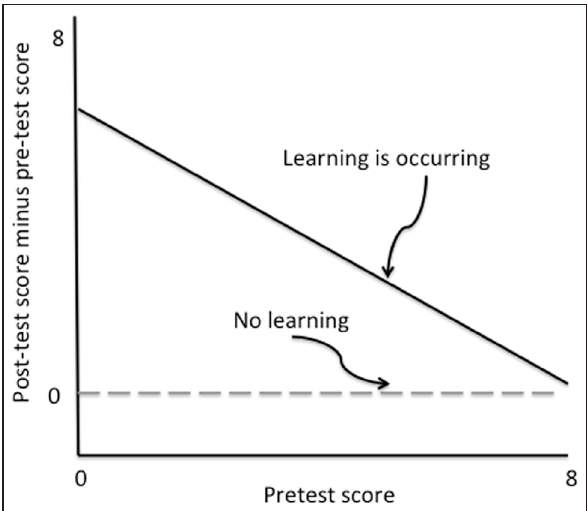
Figure 6: Expected relationship between pre-test score and learning difference (post minus pre-test) when learning occurs versus when it does not occur. If learning occurs, we predict that the learning difference is highest for participants with low pre-test scores, and declines to zero for participants with perfect pre-test scores. Partici- pants with perfect pre-test scores cannot demonstrate learning based on the questions asked. In contrast, if there is no learning, we no relationship between pre- test scores in the study and the post-pre learning differ- ence (a line with zero slope). A steeper negative slope will tend to show that more learning has occurred.